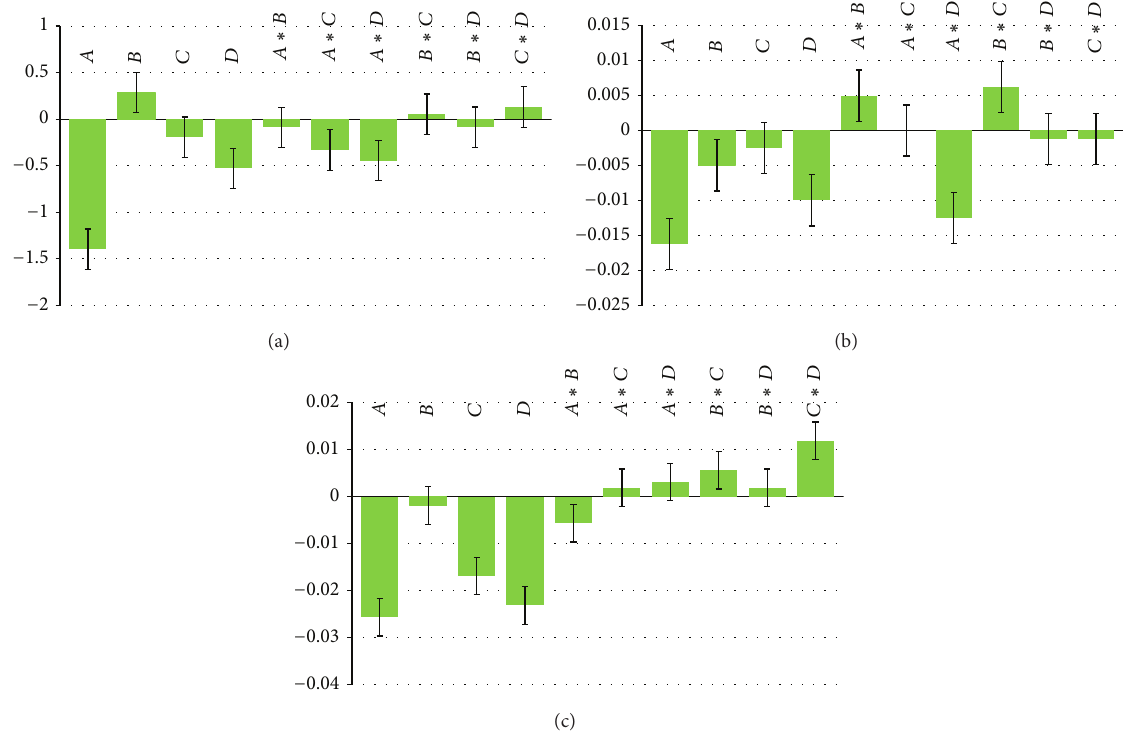
Figure 4: Scaled and centered coefficient of variation (%) of (a) resolution factor, (b) tailing factor of drug, and (c) tailing factor of I.S. during robustness studies.